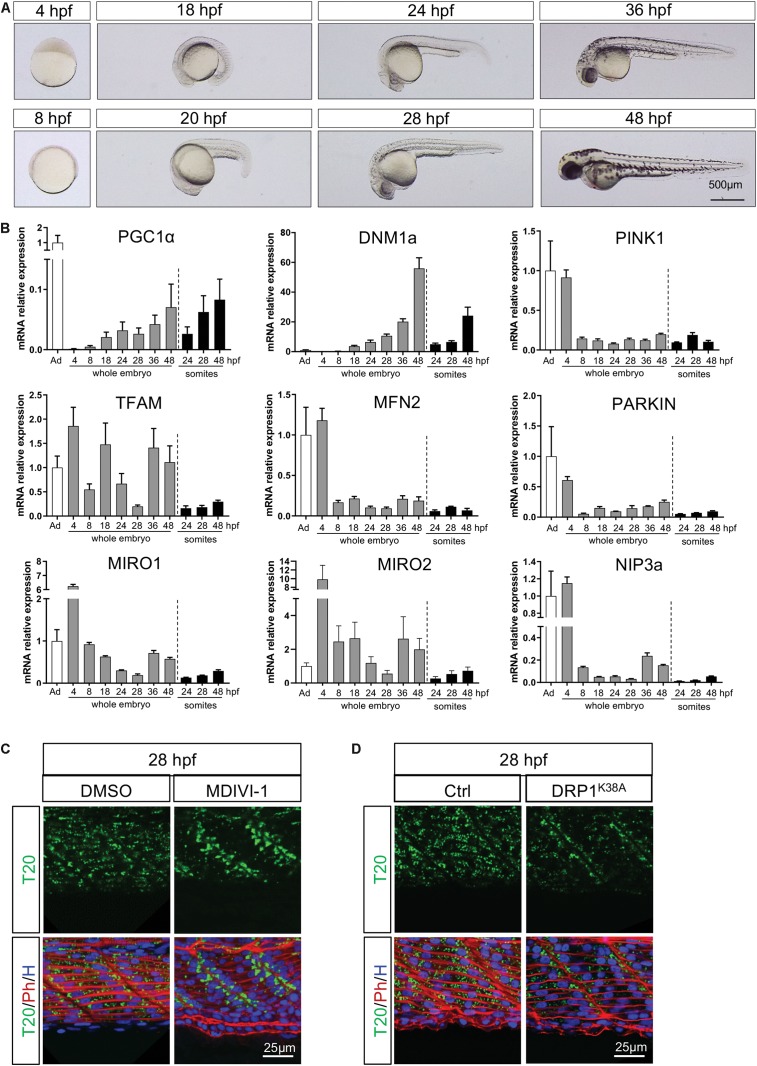
Temporal configuration of mitochondrial biogenesis, fusion, fission, mitophagy and transport through embryogenesis. (A) Representative pictures illustrate the different stages of zebrafish development used for quantitative RT-PCR. (B) Gene expression of key mitochondrial actors in whole embryos or dissected somites. Values are estimated using the 2–ΔΔCT method. Gene expression is normalized to 18S and compared to adult zebrafish muscle (bars are mean ± SEM). (C) Confocal imaging of mitochondrial network (Tomm20, T20; green) counterstained with Phalloidin (Ph; red) and Hoescht (H; blue) at 28 hpf in presence or absence of the fission inhibitor MDIVI-1 incubated since 24 hpf. (D) Confocal imaging of mitochondrial network (Tomm20, T20; green) counterstained with Phalloidin (Ph; red) and Hoescht (H; blue) at 28 hpf in embryos injected with mRNA encoding for the dominant negative DRP1 or with a mock at the one-cell stage zygote.